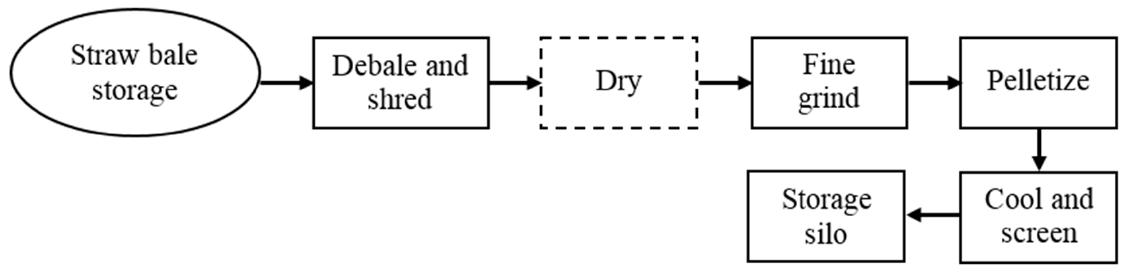
Figure 3. Sequence of operations at the pellet plant to produce